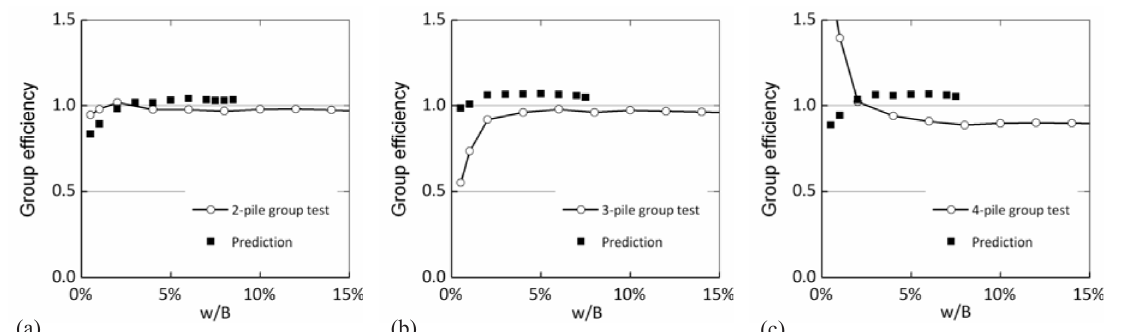
Fig. 19. Comparison of group efficiency calculated for measured and predicted pile group response in dense sand ( S/B = 3): (a) 2-pile group; (b) 3-pile group; (c) 4-pile